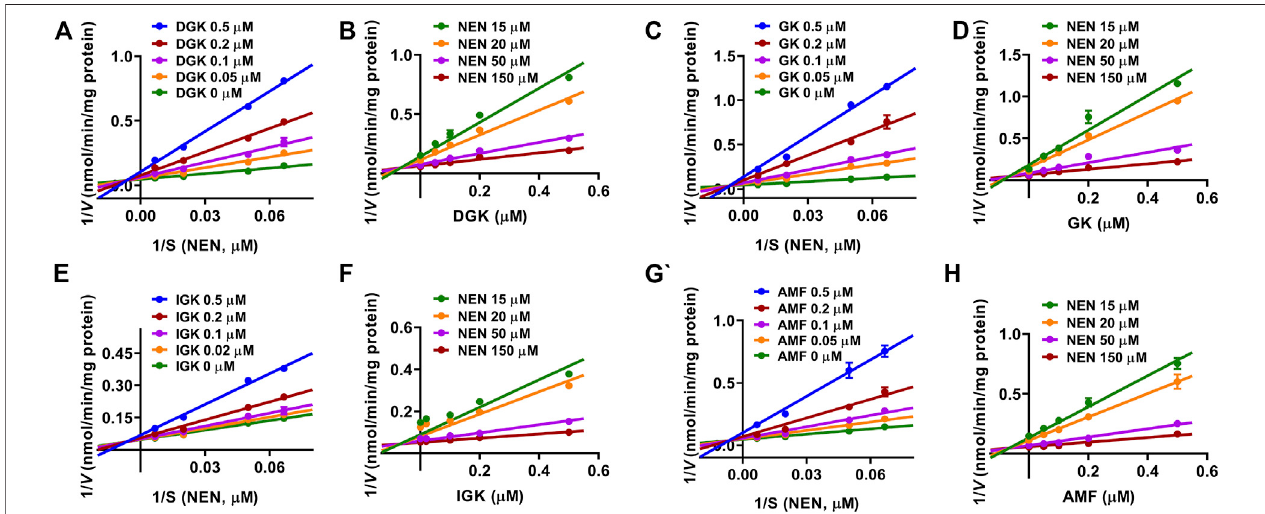
FIGURE 4 | The Lineweaver – Burk (Left) and Dixon (Right) plots of four identi fi ed bi fl avones. (A, B) DGK, (C, D) GK, (E, F) IGK, (G, H) AMF. Data are shown as the mean ± S.D. ( n = 3). Each line represents the line of best fi t to the data.